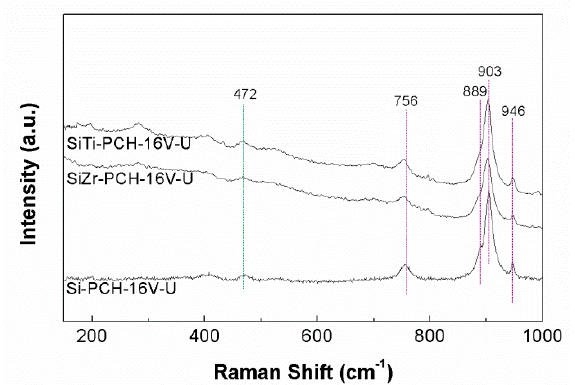
Figure 9. Raman spectra of Si-PCH-16V, SiZr-PCH-16V and SiTi-PCH16V catalysts selective oxidation of H 2 S reaction. Reaction conditions: 0.05 g of catalyst; total flow of 130 mL min − 1 ; reaction temperature of 180 °C; H 2 S/air/He molar ratio of 1.2/5.0/93.8.